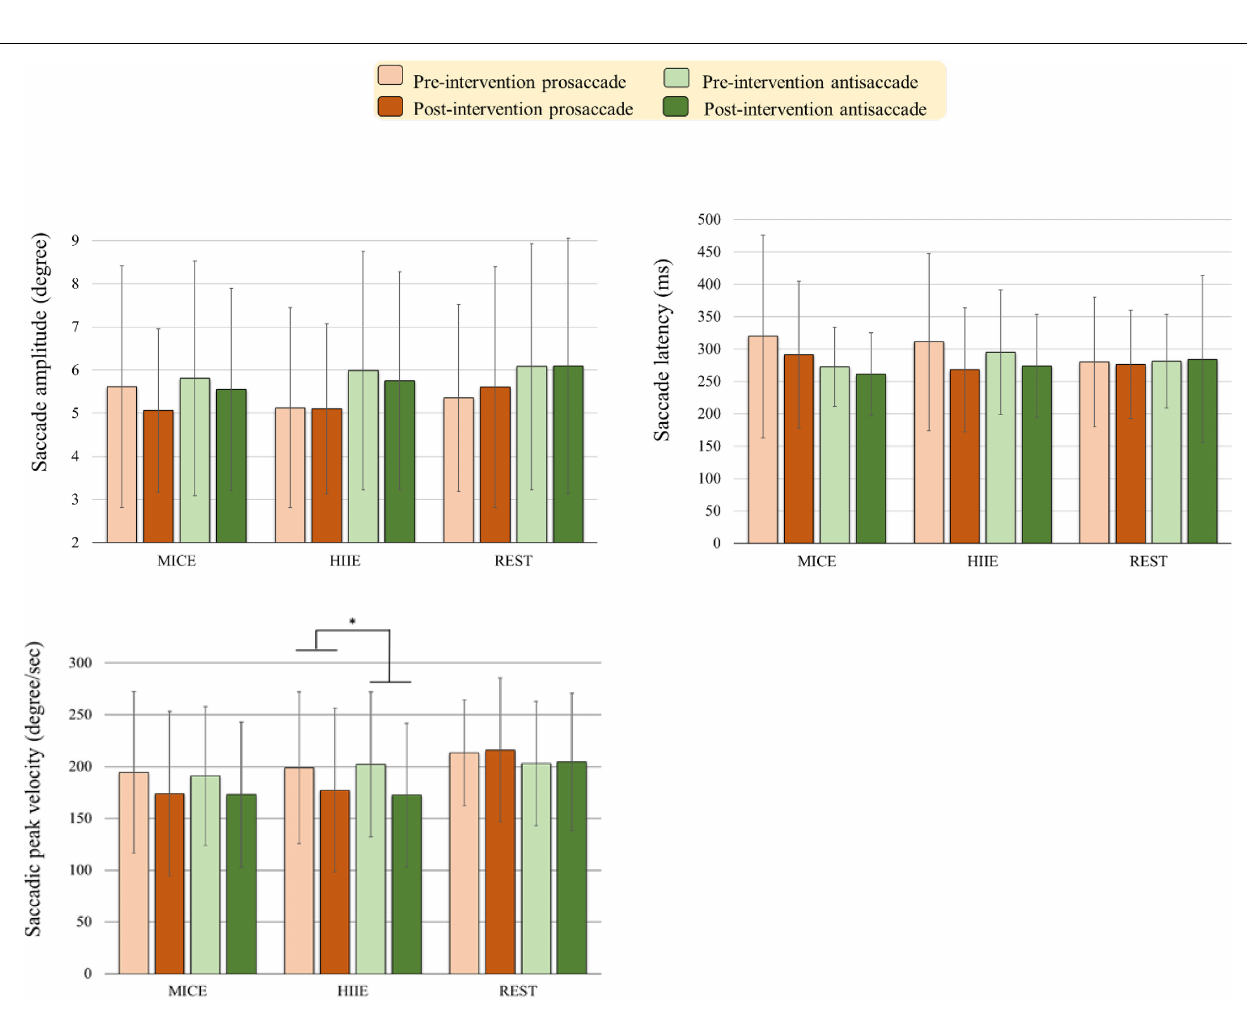
FIGURE 3 | Oculomotor performance [i.e., Saccade amplitude, saccade latency, fixation duration, and saccadic peak velocity] (mean ± SD) in the prosaccadic and antisaccadic tasks for the moderate intensity continuous exercise (MICE) and high-intensity interval exercise (HIIE) modes before and after a single bout of exercise, and one non-exercise-intervention (REST) before and after resting (* p <